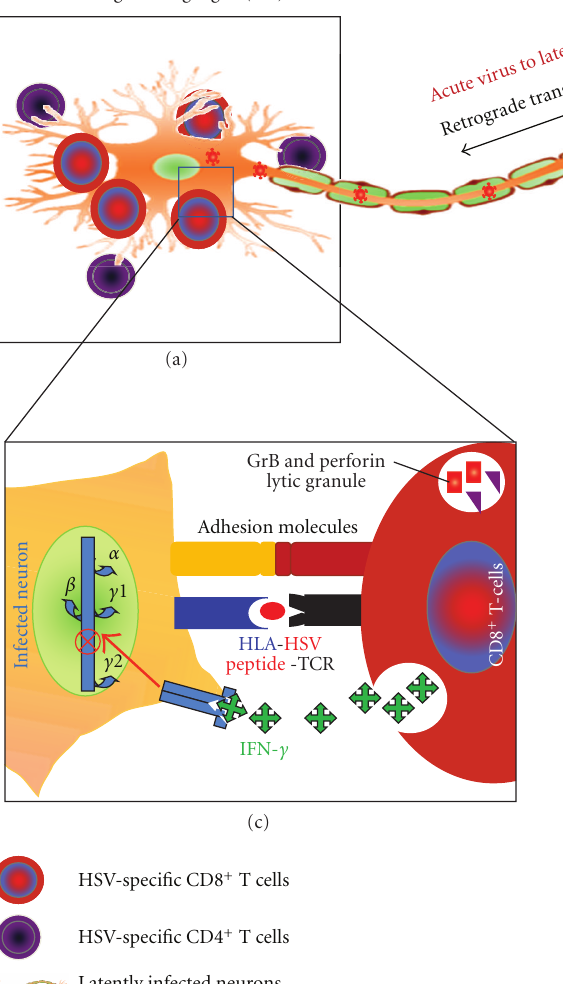
Figure 2: A model of CD8 + T-cell monitoring of HSV-1 latency in sensory ganglia. (a) During a primary infection (a ff ecting the cornea of the eye), HSV-1 invades the termini of sensory neurons, the nucleocapsid travels by retrograde axonal transport to the neuron cell bodies within the trigeminal ganglion (TG), viral DNA is inserted into the nucleus, and a brief period of virus replication ensues (b). An initial infiltration of macrophages and T cells gives rise to an infiltrate dominated by CD4+ and CD8+ T cells and macrophages that persists for the life of the animal (c). The CD8+ T cells associate closely with the neuron cell bodies and directly monitor viral gene expression in neurons by detecting epitopes of viral epitopes that are produced early in a reactivation event and presented on the surface of the neuron within MHC class I. The CD8+ T cells force the viral genome into a quiescent state through IFN- γ production (early in reactivation) or through the release of lytic granules (at later stages of reactivation). A similar model can be extrapolated to genital herpes infection with